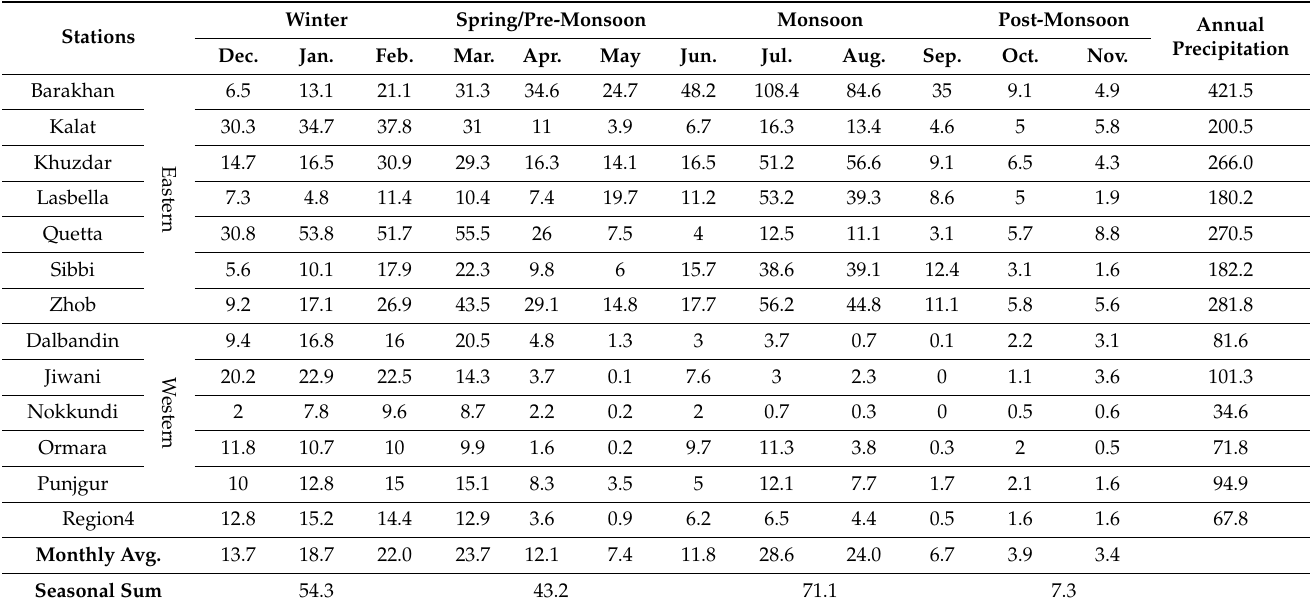
Table 1. Average precipitation (mm) from 1977 to